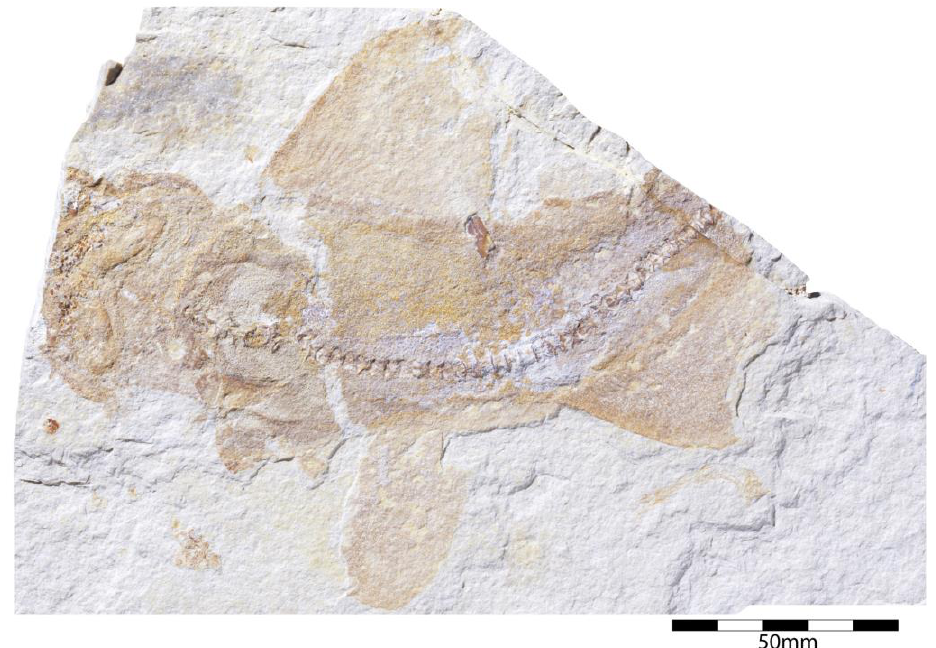
Figure 18. Holotype specimen of † Paracestracion viohli Kriwet, 2008 [57] (JME Scha 728) from the upper Kimmeridgian of Schamhaupten.